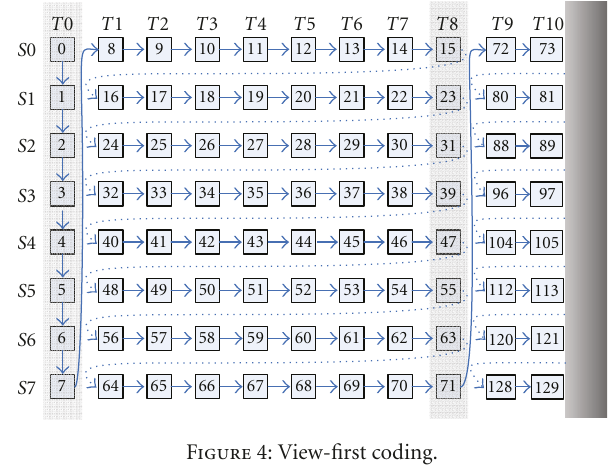
Figure 4: View-first coding.